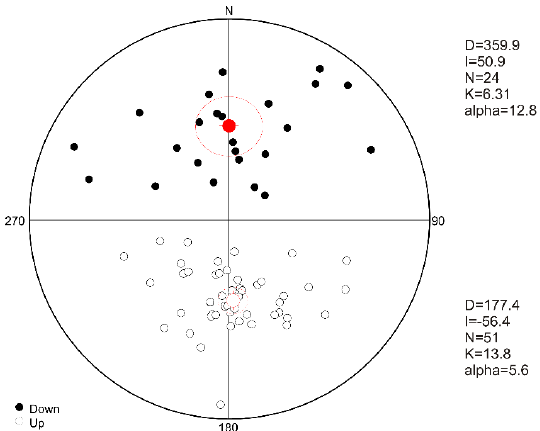
Figure 4. Orthogonal vector plots of alternating field (AF) and thermal (TH) demagnetization of representative samples ( A – F ) of Dafnero sections. Solid circles indicate horizontal component; open circles indicate vertical component. Demagnetization steps in mT or °C. NRM is the natural remanent magnetization.